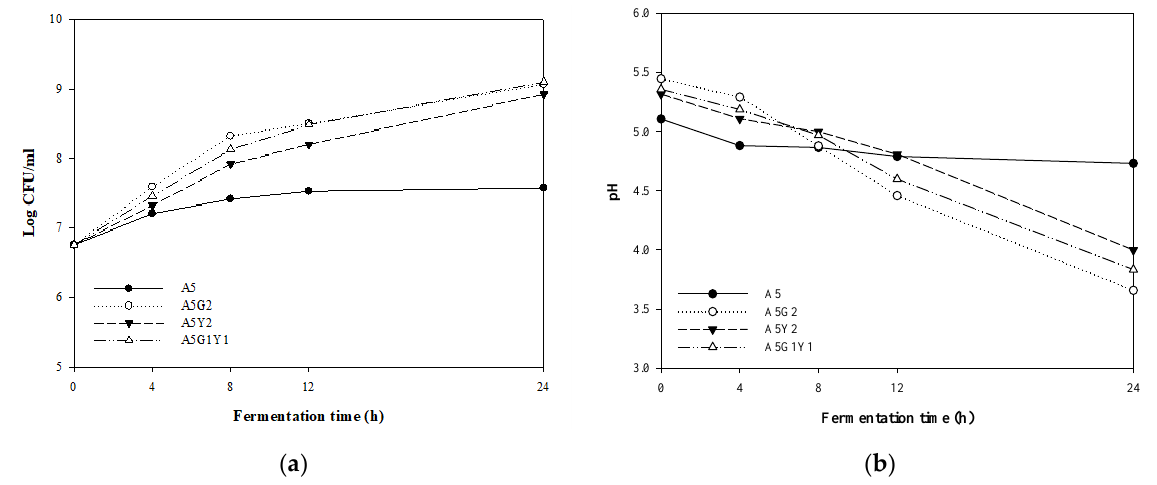
Figure 2. Comparison of changes in the viable cell counts ( a ) and pH ( b ) of MKJW-fermented A. capillaris during 24 h. A5, A. capillaris 5%; A5G2, A. capillaris 5% + G. bimaculatus 2%; A5Y2, A. capillaris 5% + yeast extract 2%; A5G1Y1, A. capillaris 5% + G. bimaculatus 1% + yeast extract 1%.